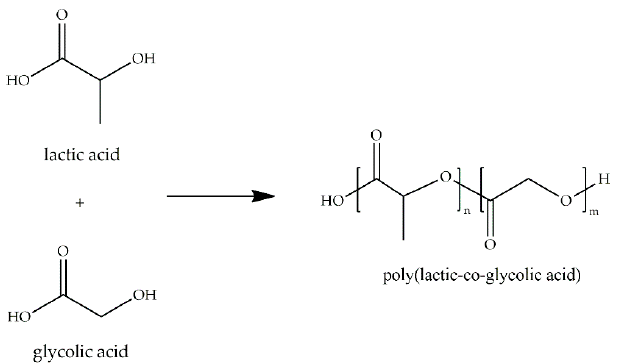
Figure 16. Molecular structure of poly(lactic- co -glycolic acid) (PLGA) and its monomers.